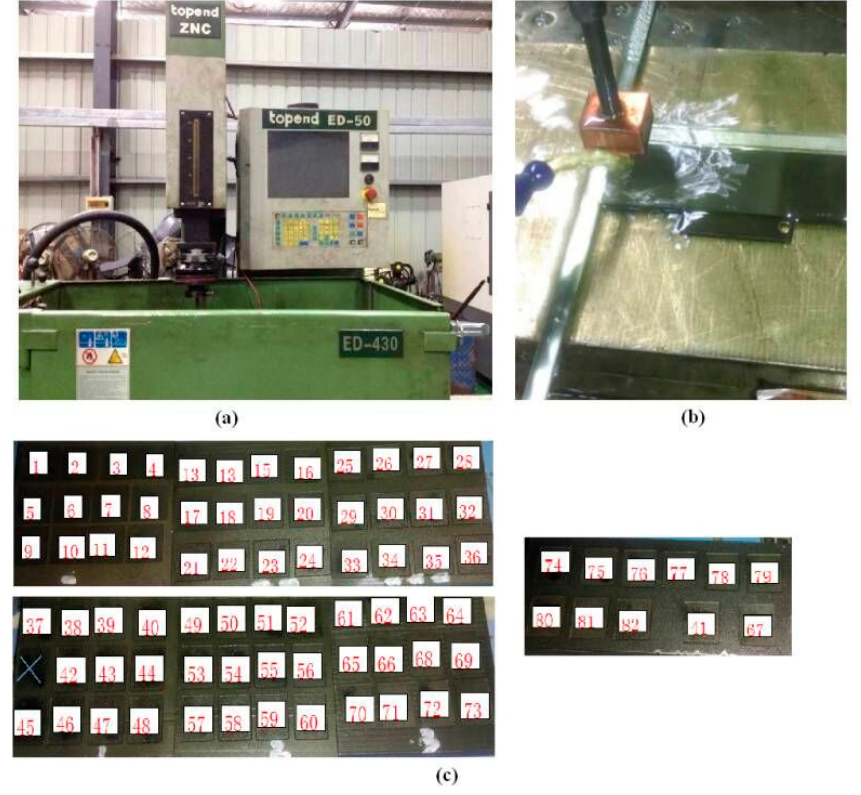
Figure 9. Experimental setup and workpiece; ( a ) Topend ED − 50 EDM machine; ( b ) workbench; ( c ) workpiece. Reprinted with permission from ref. [28]. Copyright 2021 Copyright Springer Nature. Table 4. Test results of four optimization algorithms on the MRR single-objective optimization.